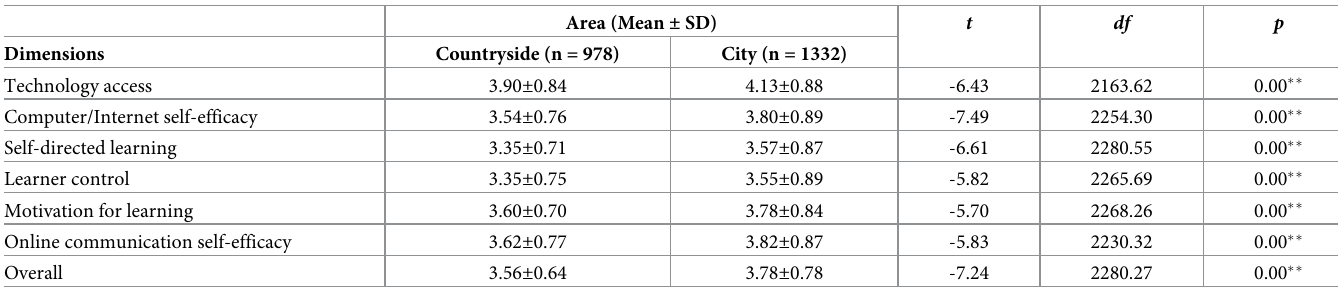
Table 4. Independent samples t-test of